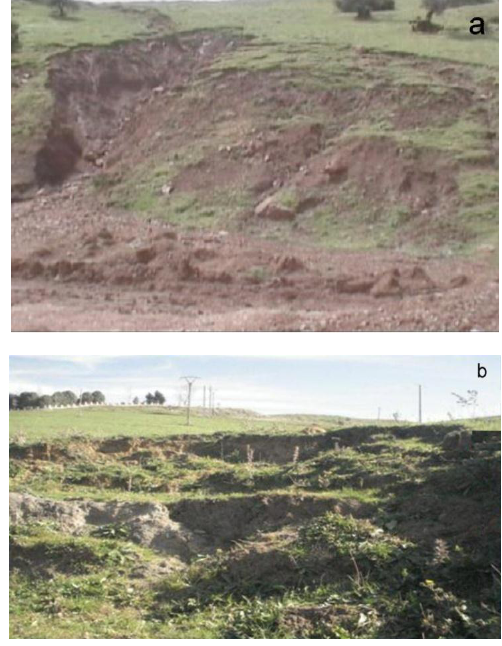
Figure 6: Photographs showing bank erosion and landsliding in the Bou Adjeb and Khemakhem